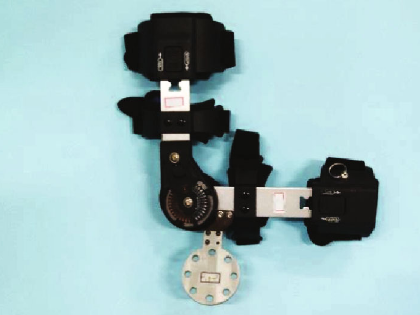
Figure 1: The orthosis of right upper limb.